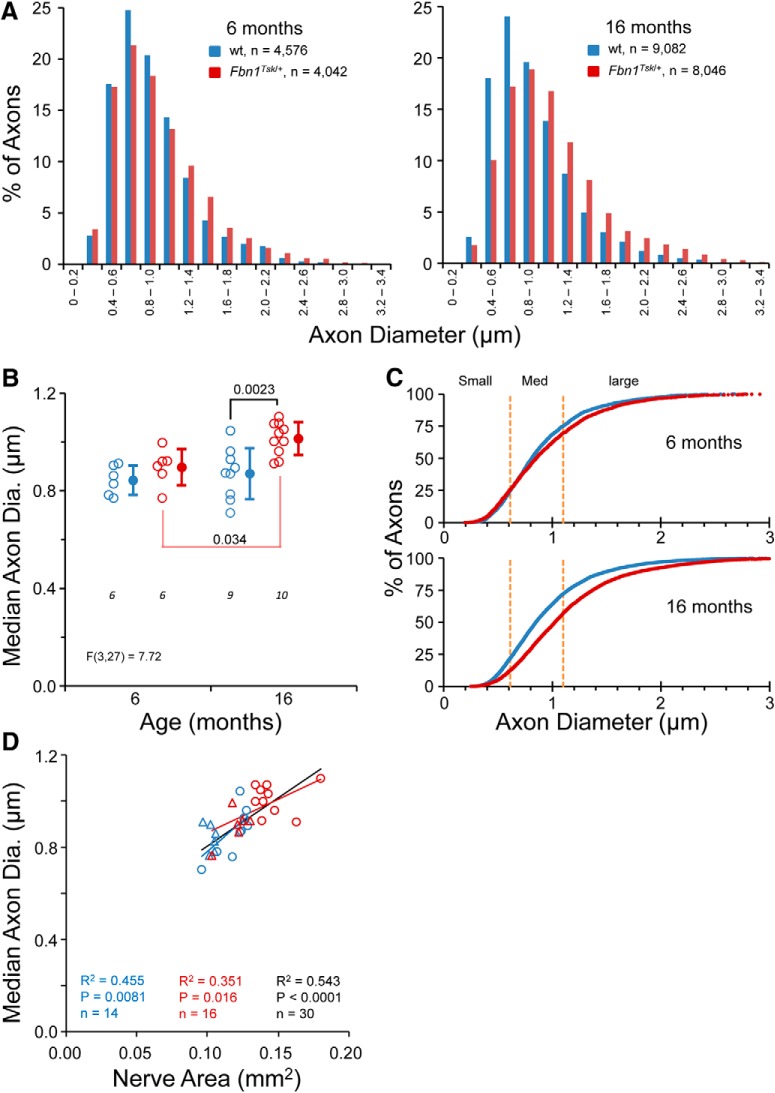
Enlargement of optic nerve axons in Fbn1Tsk
/+ mice. Histograms of axon diameters (A) show a shift toward larger axons for Fbn1Tsk
/+ (red) as compared to wt mice (blue) at six months (A, left), which becomes more pronounced at 16 months (A, right). Comparison of median axon diameter for individual mice shows a similar age-dependent increase in axon size in Fbn1Tsk
/+ (red) as compared to wt (blue) optic nerves (B, open symbols: individual mice, closed symbols: mean ± SD, numbers of mice indicated in italics below each group). Cumulative plots of axon diameters shown in panel A demonstrate a shift to larger axons for all size categories defined by the first, second and third and fourth quartiles of wt axons (small, medium, and large; orange dotted lines) for Fbn1Tsk
/+ (red) as compared to wt mice (blue) at 16 months of age (C). Axon diameter was significantly correlated with optic nerve area (D; blue symbols, wt; red symbols, Fbn1Tsk
/+; triangles, six months; circles, 16 months). The best-fit line, R
2, p value, and number of data points are shown for wt and Fbn1Tsk
/+ mice separately and for all mice combined (D, red, blue and black lines and text, respectively).